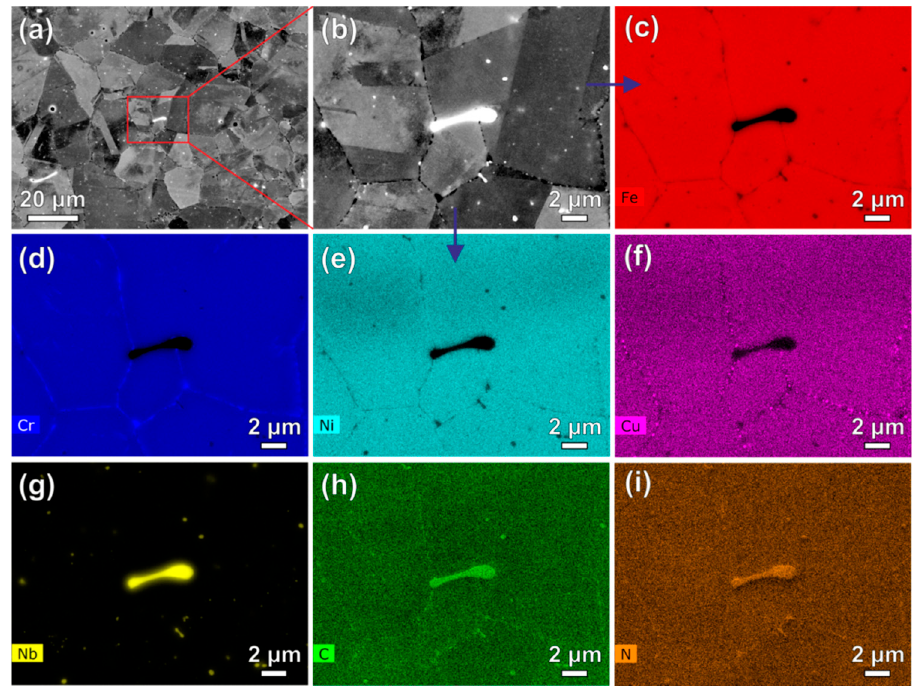
Figure 5. Back-scattered electron (BSE) images of the long-term (5000 h at 923 K) aged Super304H steel sample with relatively low ( a ) and high ( b ) magnifications. ( c–i ) are the EDS maps of elements Fe, Cr, Ni, Cu, Nb, C and N, respectively, corresponding to the identical sample region in ( b ).